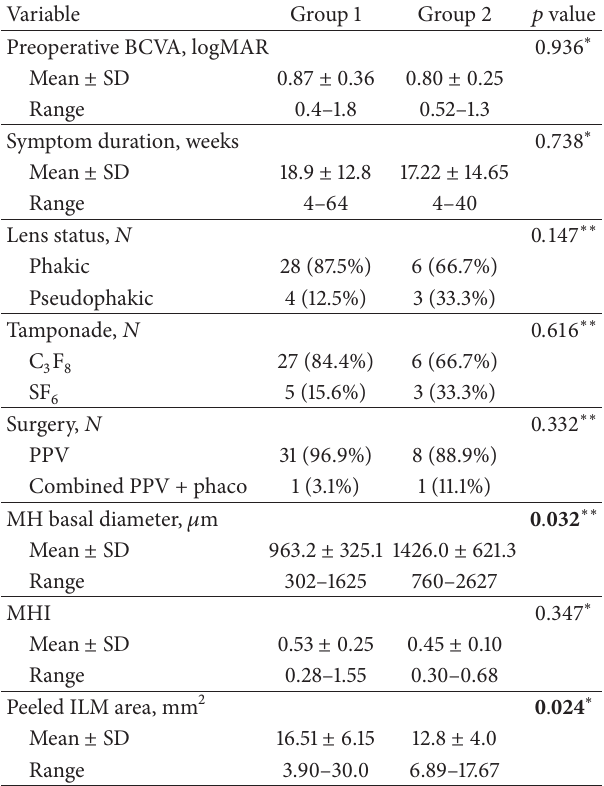
Table 2: Clinical characteristics of participants.